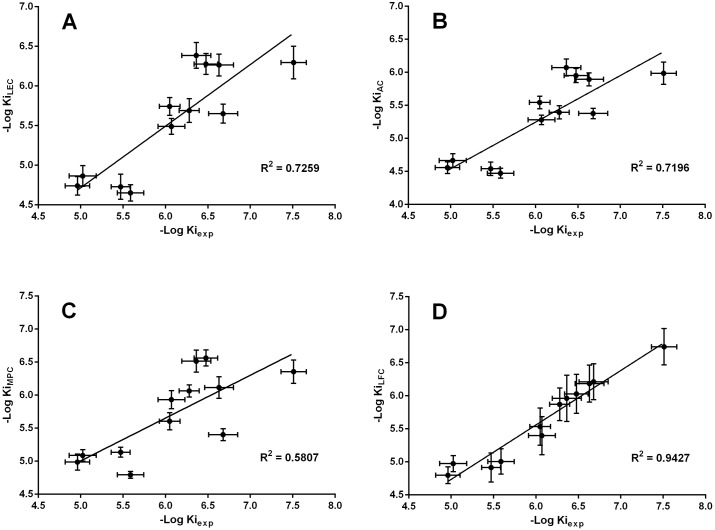
The four diagrams show the variations of -Log of KiLFC (A), KiAC (B), KiMPC and KiLFC versus -Log Kiexp.The data are presented as ± SEM.